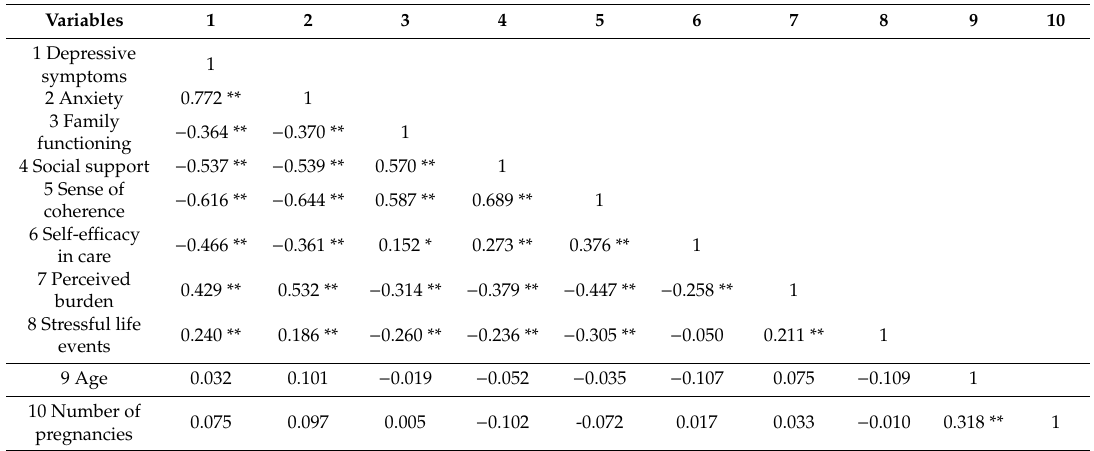
Table 2. Correlation matrix of measures of study variables.